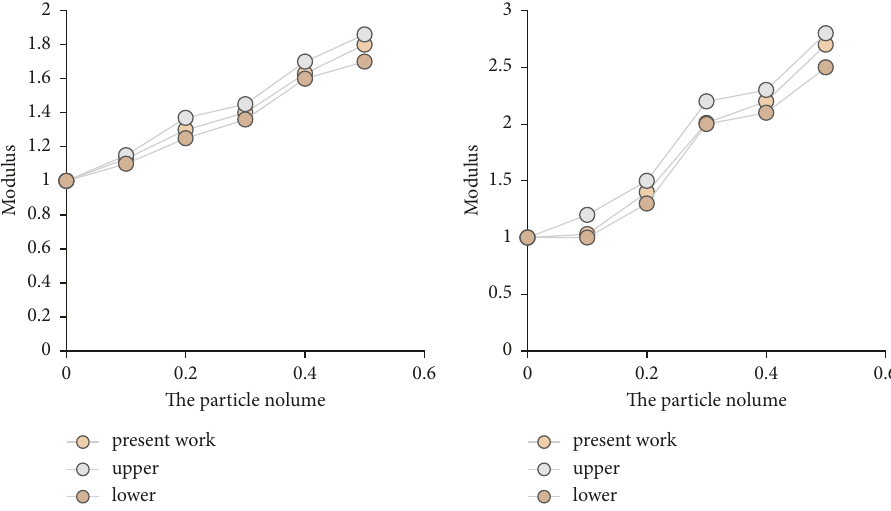
Figure 9: Schematic diagram of bulk modulus and shear